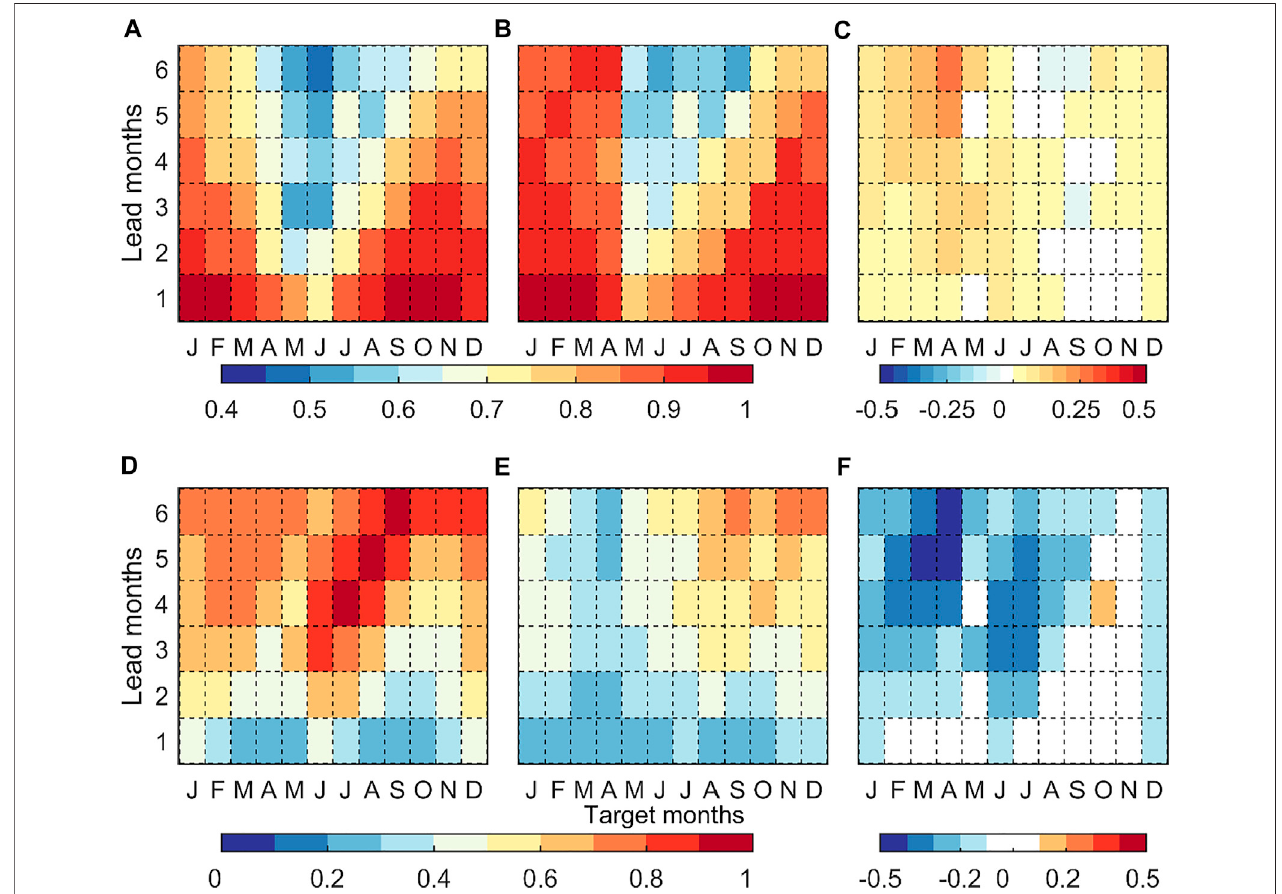
FIGURE 5| ACC and RMSE ofthe Niño3.4 SSTAas a function of the target month and lead month obtained using the (A, D) FIO-CPSv1.0; (B, E) FIO-CPS v2.0; (C, F) the differences between FIO-CPS v2.0 and FIO-CPS v1.0.